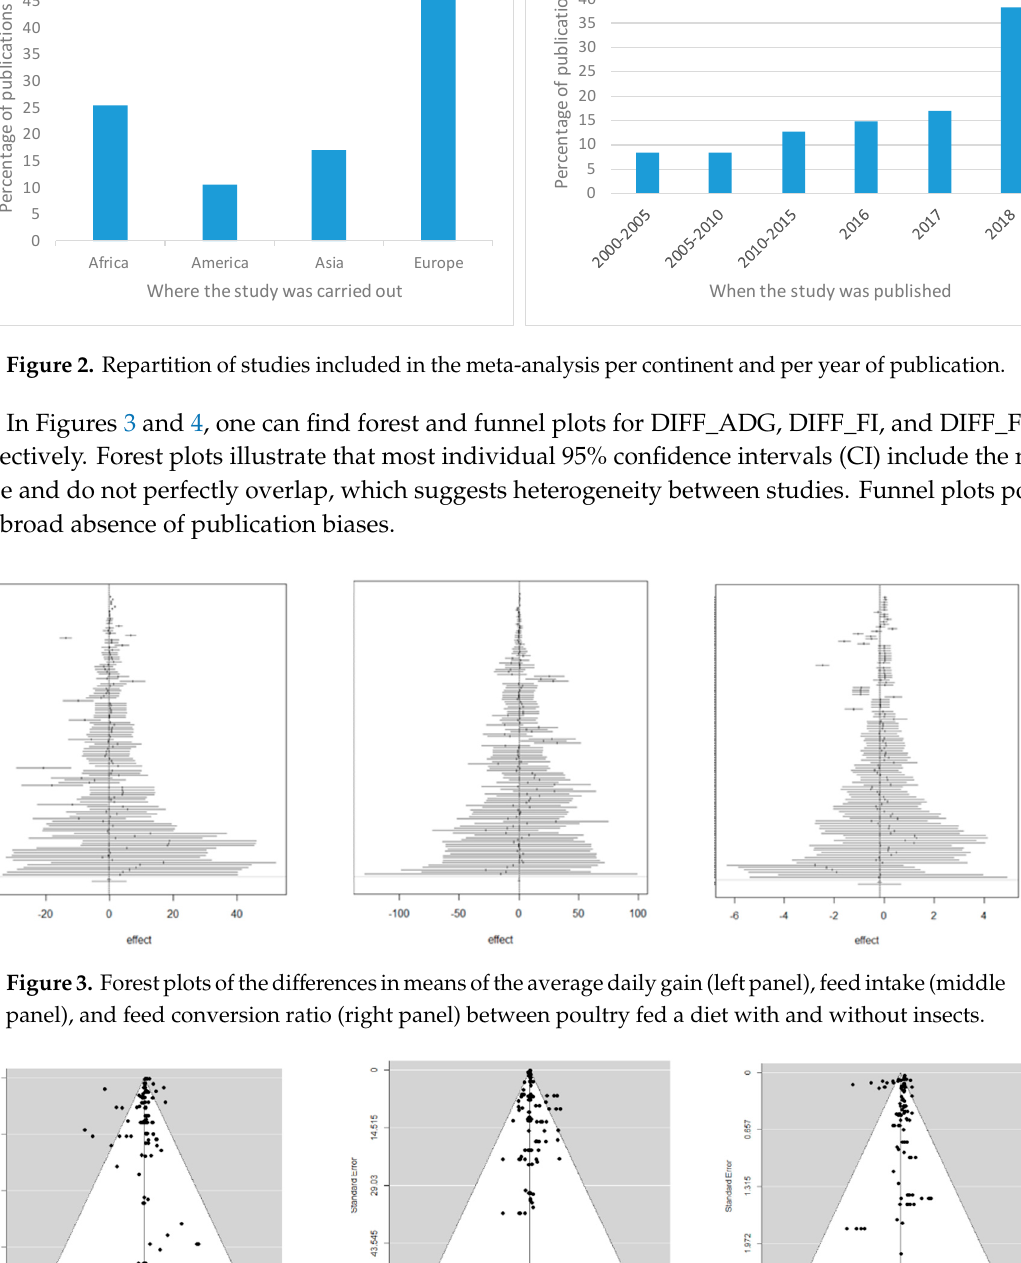
Table 1. Results of the full model of analysis without accounting for sources of heterogeneity.